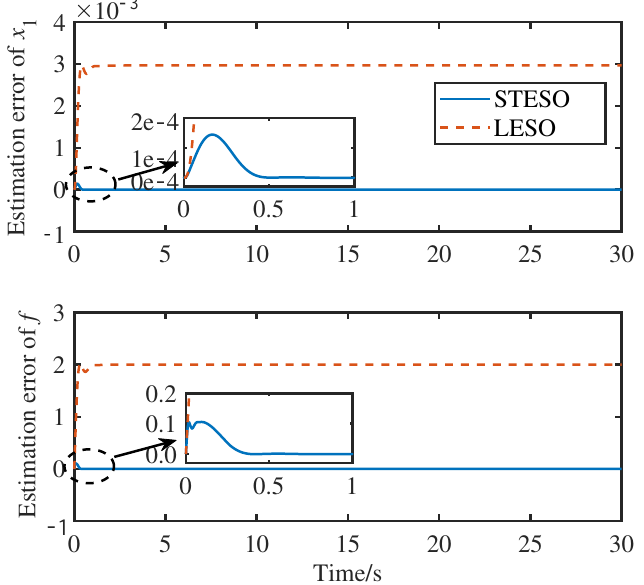
Figure 2. Simulation results of ramp disturbance—estimation error: STESO (solid line); LESO (dashed line).